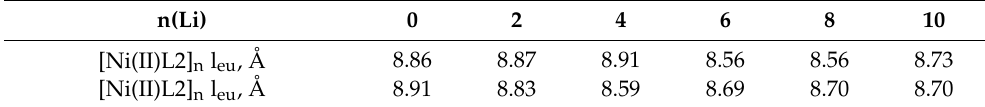
Table 3. Elementary unit length (l eu ) of the polymers with L2 upon